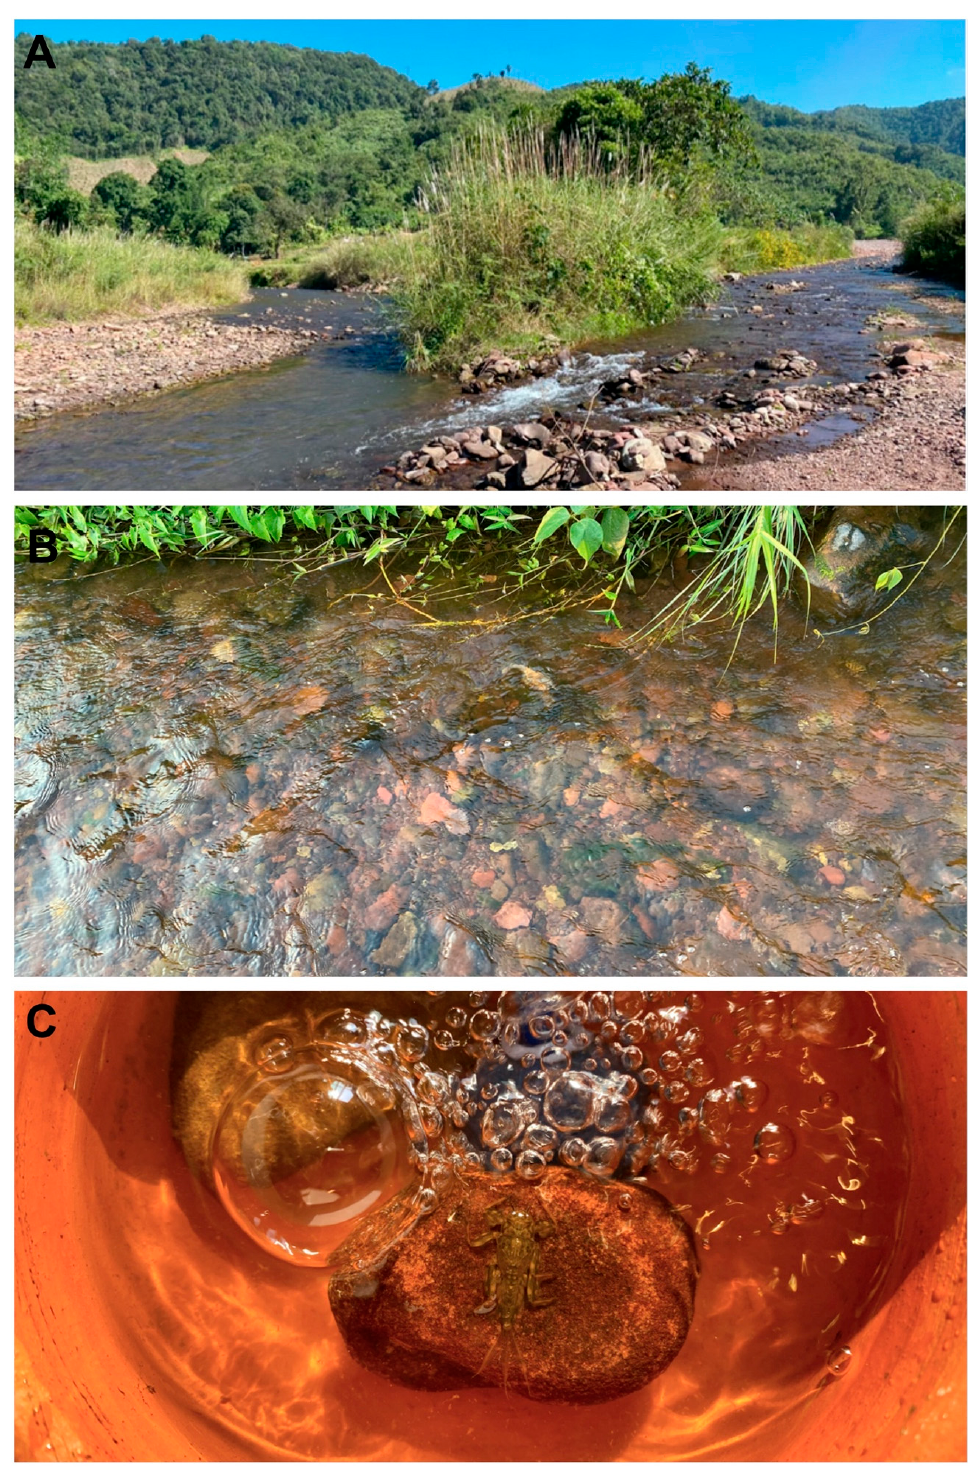
Figure 8. Vietnamella nanensis sp. n. ( A ) type locality-Wa river, Nan province, Thailand; ( B ) microhabitat; ( C ) rearing chamber.